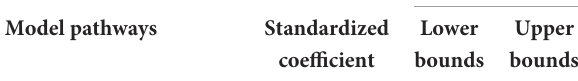
TABLE 3 Direct effects, indirect effects, and the corresponding 95% confidence intervals between the study